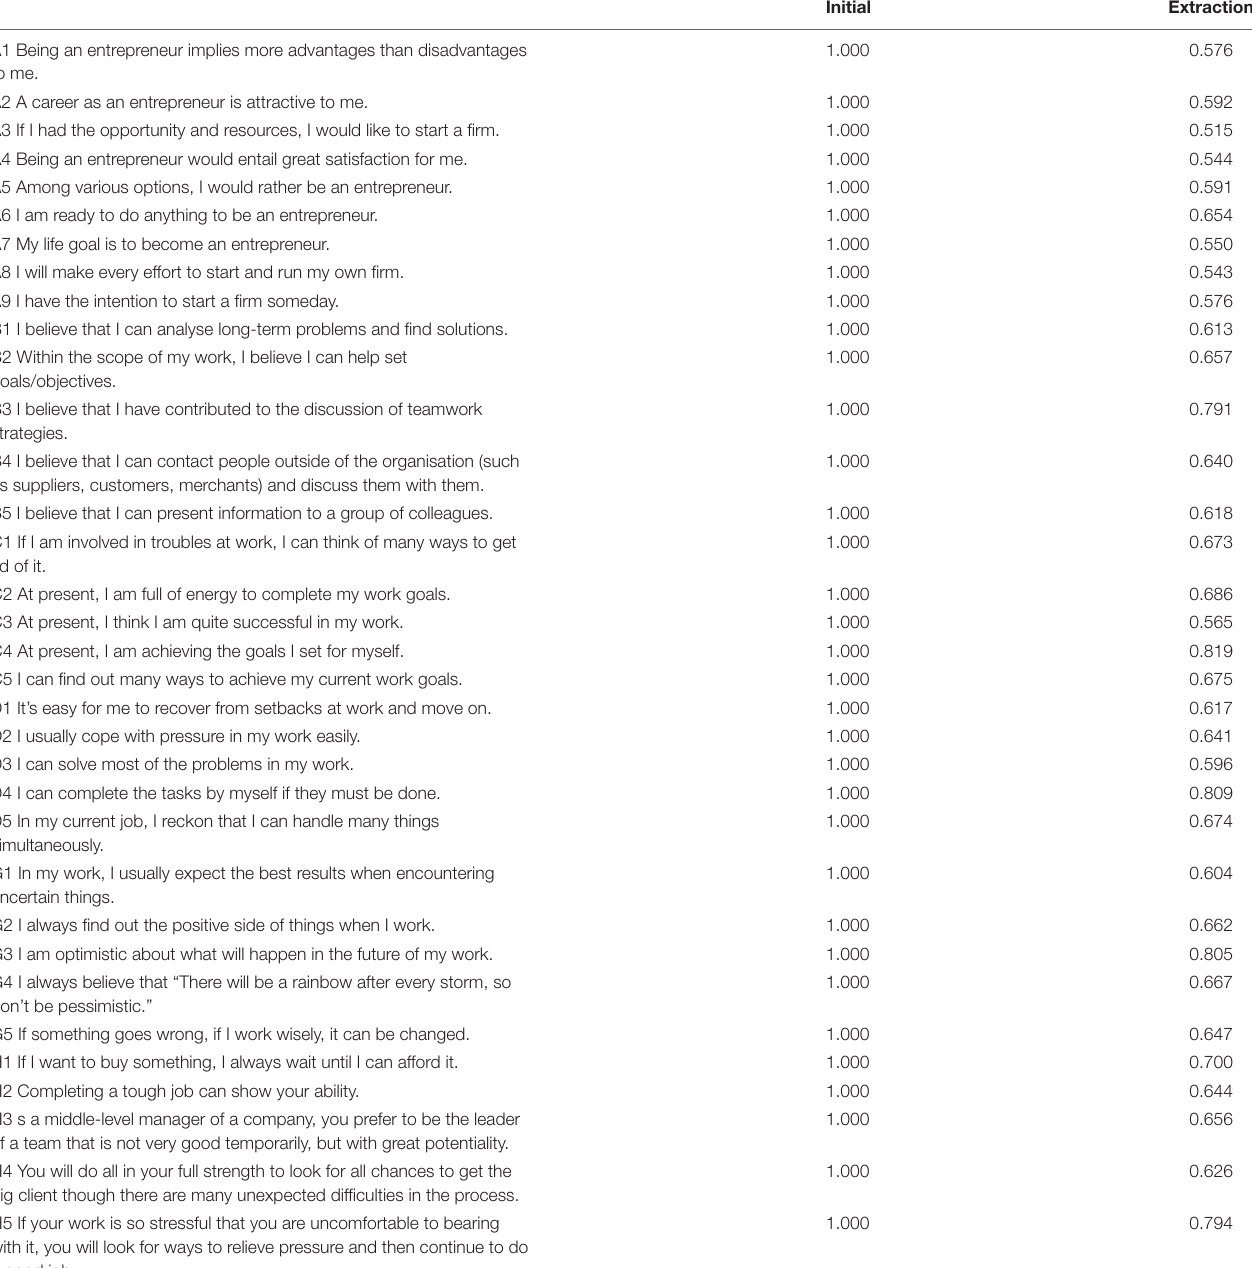
TABLE 4 | Common metre of each indicator.